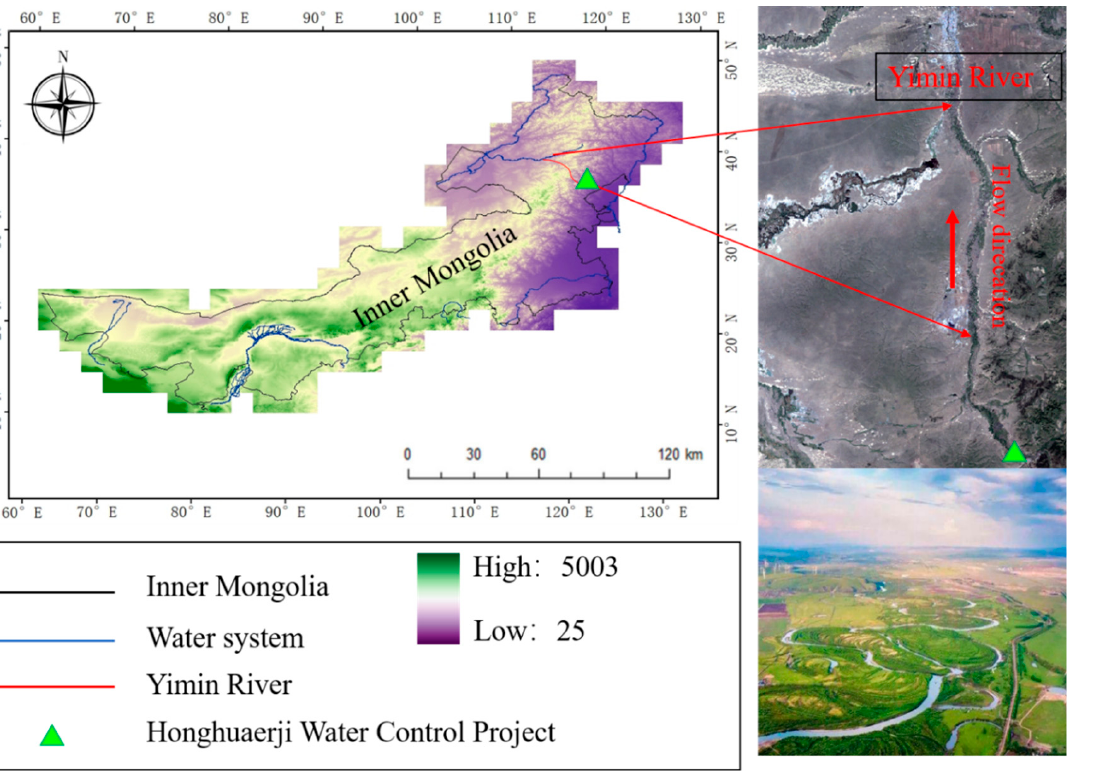
Figure 1. Study area location.